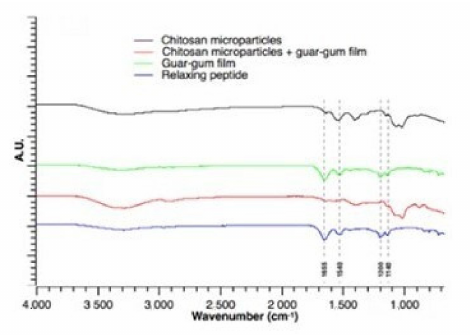
Figure 1. FTIR spectra of free peptide (relaxing peptide) ( − ) and peptide-loaded chitosan microparti- cles ( − ), guar-gum films ( − ), and chitosan microparticles into guar-gum films ( − ).